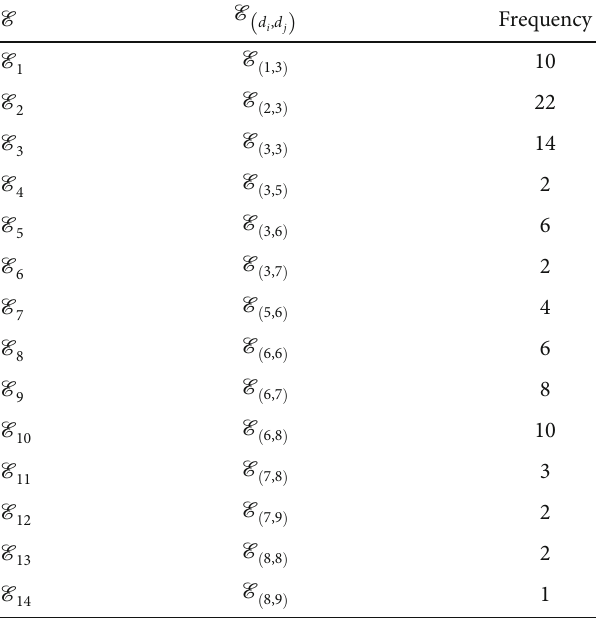
Table 4: Edge partitioning based on degree of thea fl